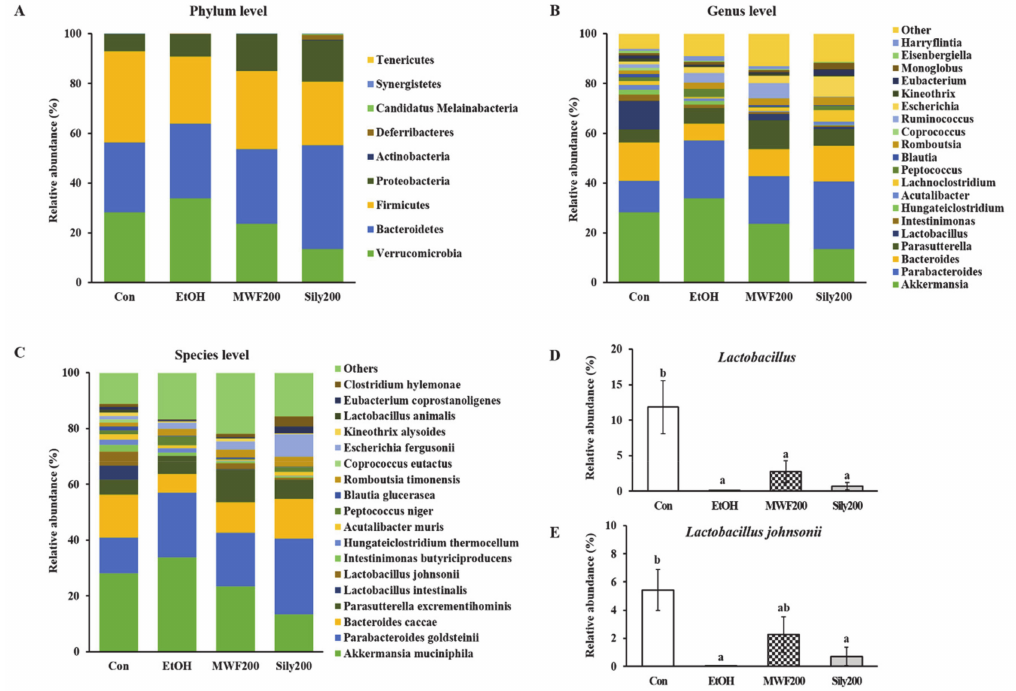
Figure 4. E ff ects of MWF on the bacterial community structures of the colon in chronic alcohol-fed rats. ( A ) Bacterial taxonomic composition at the phylum level; ( B ) genus level; ( C ) species level; ( D ) Lactobacillus genus; ( E ) Lactobacillus johnsonii species. Mean ± SE. Statistical significance was determined by one-way ANOVA, followed by Duncan’s multiple range test. Values not sharing a common letter (a, b) above the bars are significantly di ff erent among the groups at p <